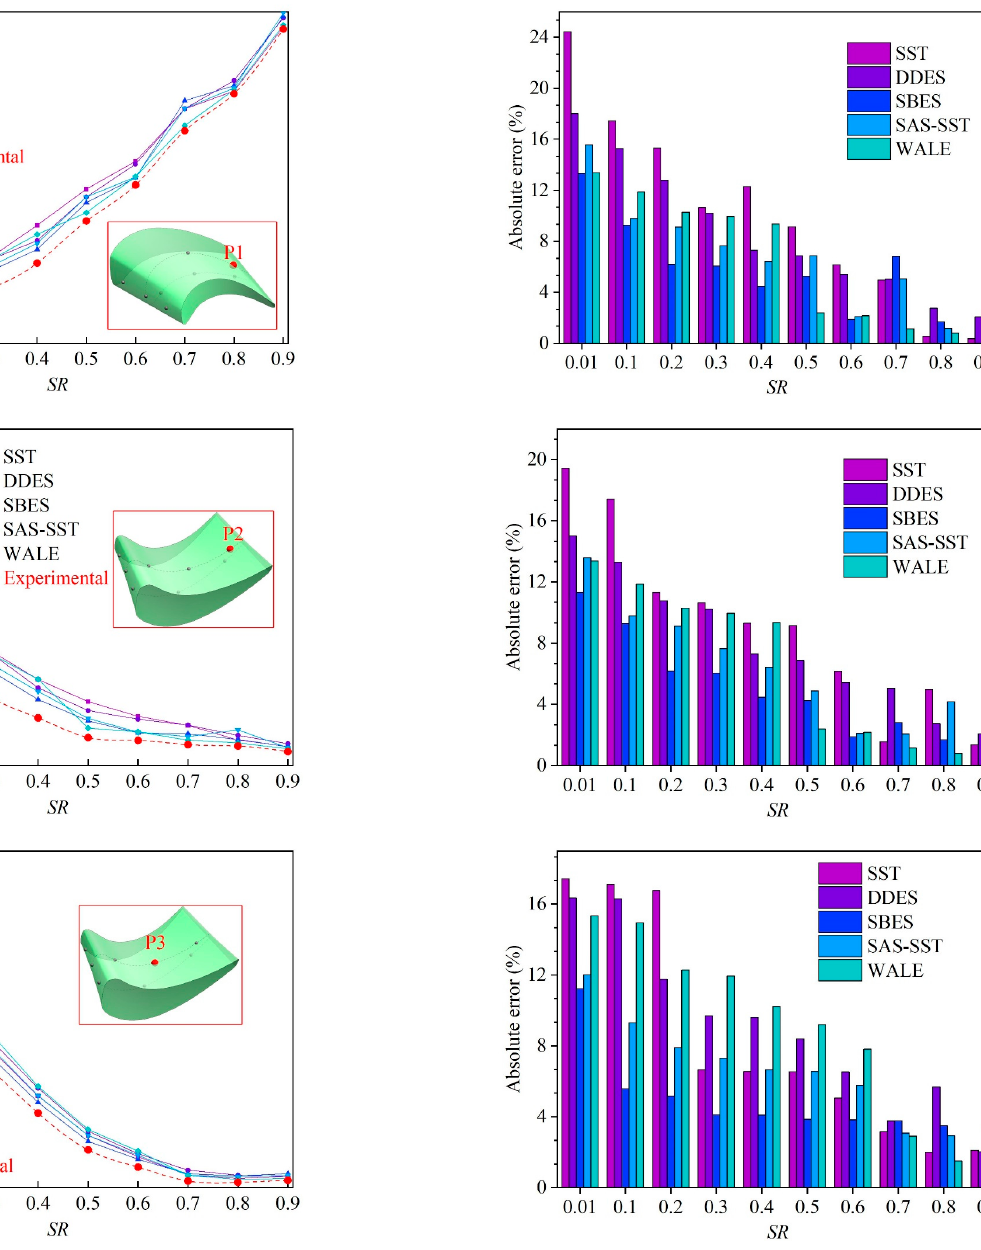
Figure 9. Pressure characteristics of measuring point on blade surface.